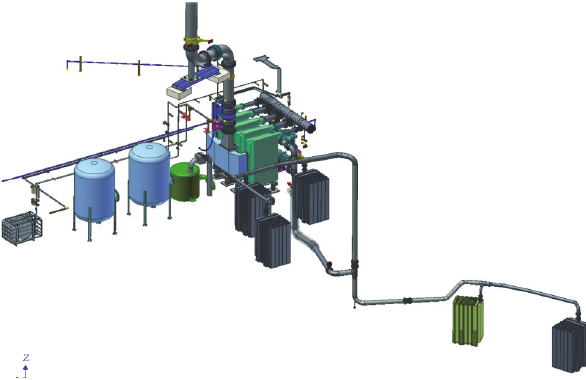
Figure 1: PCFV system layout, taken from